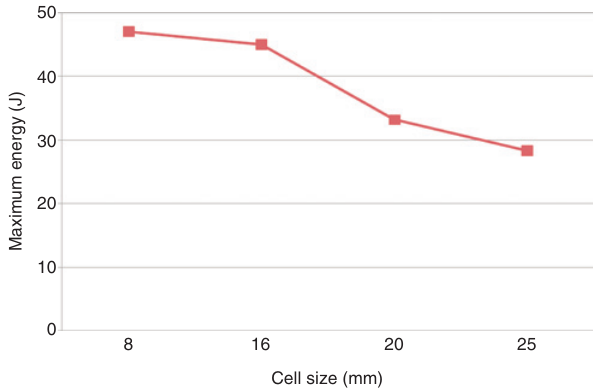
Figure 10 Maximum energy of sandwich panel of different cell size during impact.